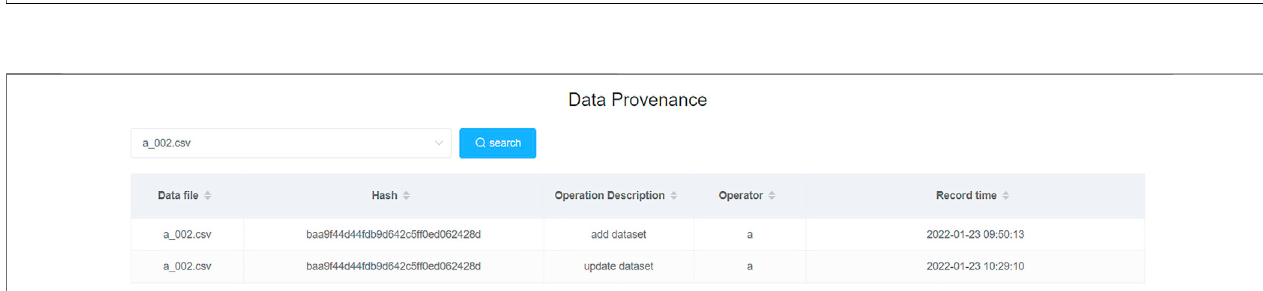
FIGURE 7 | Data provenance on the consortium blockchain. Data provenance could be carried out through referring to dataset fi les, hash values, operation description, operators, time, and other information stored on the blockchain.